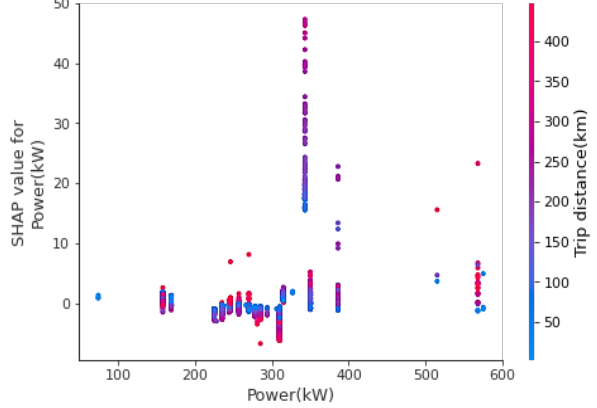
Figure 6. SHAP interaction dependence plot for power (kW) and the trip distance (km).